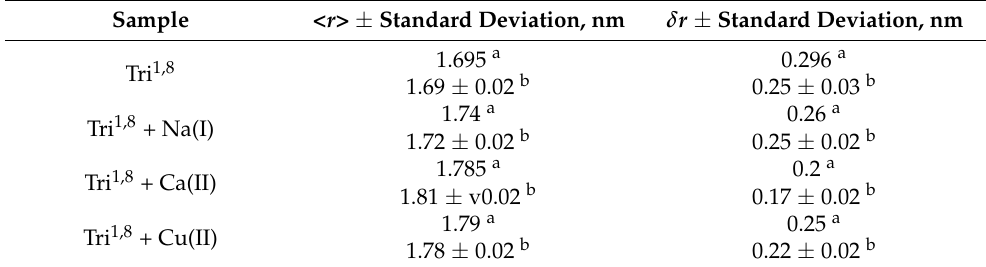
Table 1. Parameters of the Gaussian distribution between spin tance between labels; δ r , dispersion of the related distribution.